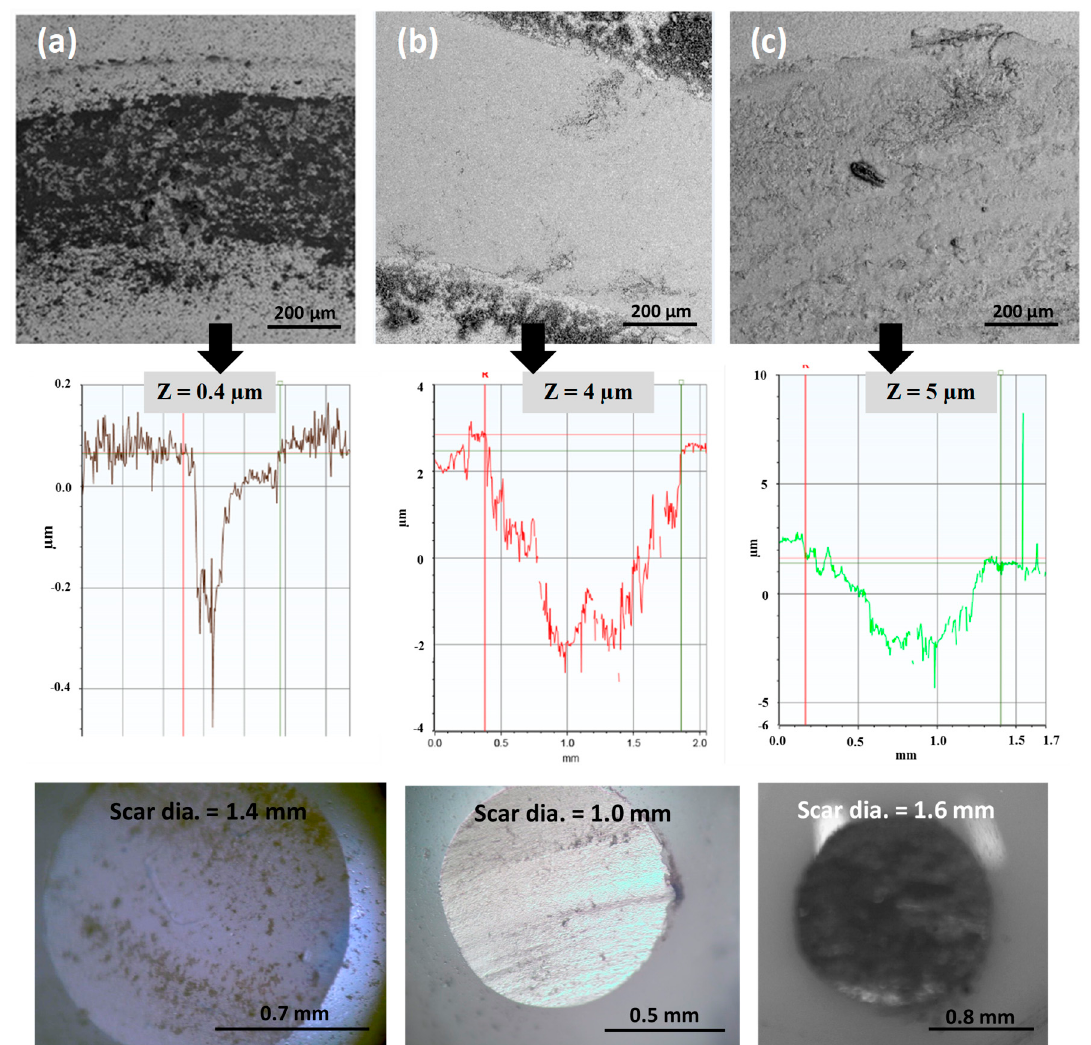
Figure 4. FESEM images, 2D profile plot showing the depth (Z) of the wear tracks and corresponding optical images of the counterface ball revealing the scar diameter of wear test conducted at ( a ) RT, ( b ) 300 °C and ( c ) 600 °C, for the micron-sized WC samples.